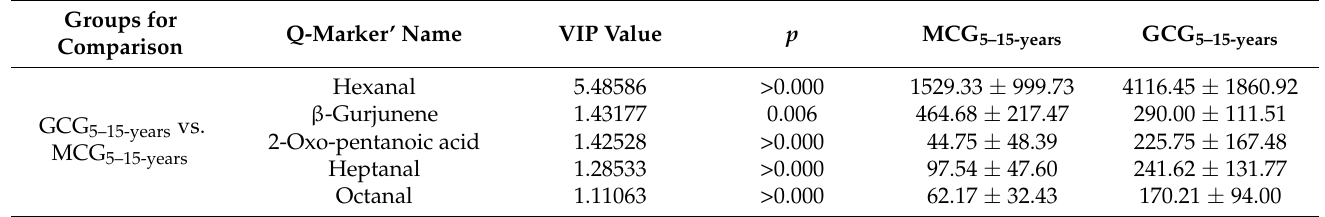
Figure 2. Multivariate statistical analysis base on volatile components from MCG 5–15-years and GCG 5–15-years . ( A ) Principal component analysis (PCA) score plots; ( B ) Orthogonal partial least squares-discriminant analysis (OPLS-DA) score plots; ( C ) S-plots; ( D ) The contents of the five cultivation-dependent markers to distinguish MCG 5–15-years and GCG 5–15-years . ( p -value ** < 0.01; *** < 0.001). Table 2. Detailed information of the five potential chemo-markers between MCG 5–15-years and GCG 5–1-5 years